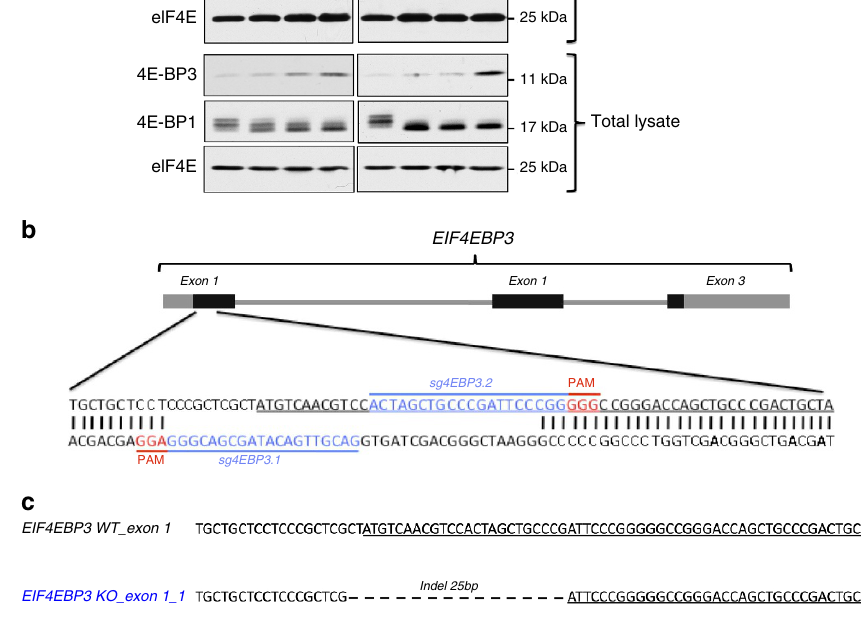
no additive effect (Supplementary Fig. 17a,b). Thus, a single treatment of mTORC1-targeting drug was sufficient to induce 4e-bp3 expression in vivo . Next, we investigated the ability of 4E-BP3 to mediate the anti- proliferative effects of mTOR inhibitors, by comparing human